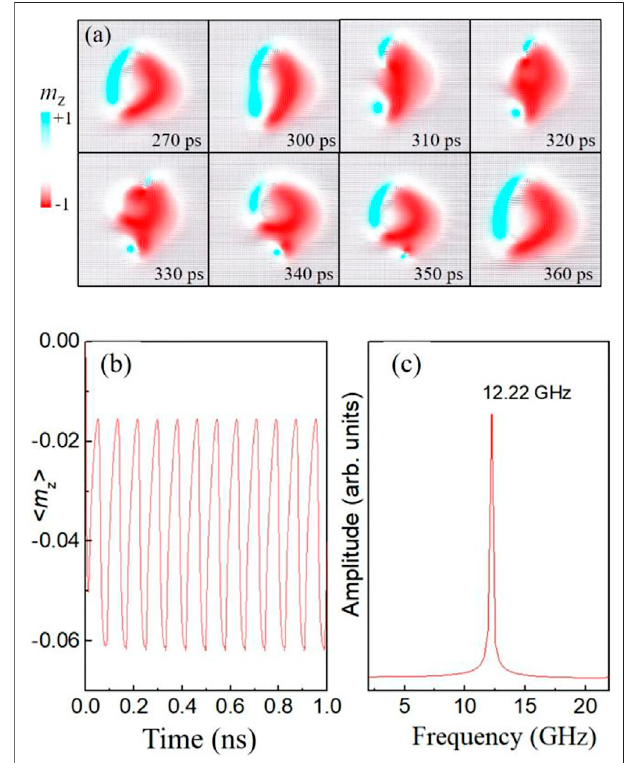
FIGURE 2 | (Color online) (A) The spin texture at different times for one oscillation period, where M S = 5.8 × 10 5 A/m, A = 1.5 × 10 − 11 J/m, K = 8.0 × 10 5 J/m 3 , α = 0.5. The current density is 36 × 10 11 A/m 2 . DMI strength is 3.5 mJ/m 2 (B) shows the < m z > as a function of time. (C) FFT amplitude spectrum of < m z > in (B)